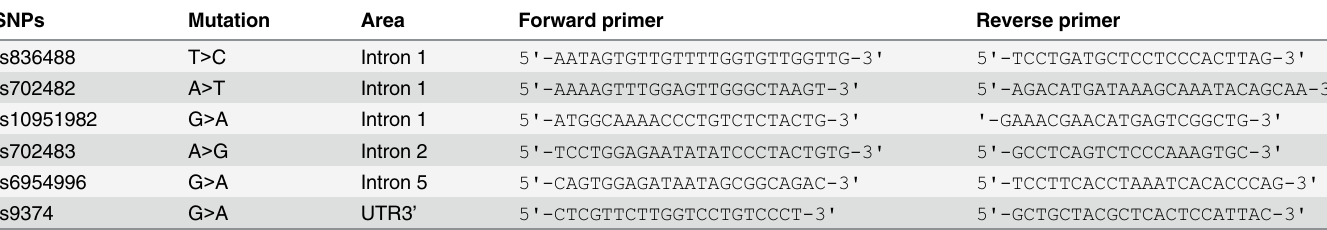
Table 1. Primer sequences for genotyping the single nucleotide polymorphisms of RAC1 gene.